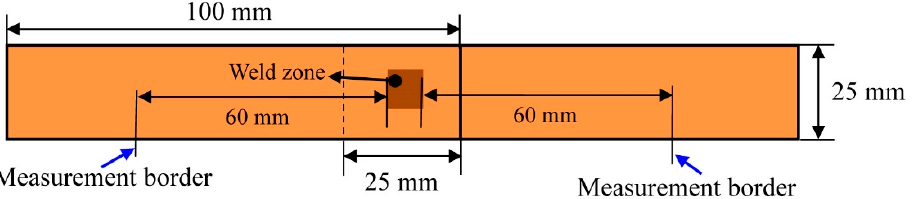
Figure 3. Schematic illustration of the joint electrical resistance measurement.